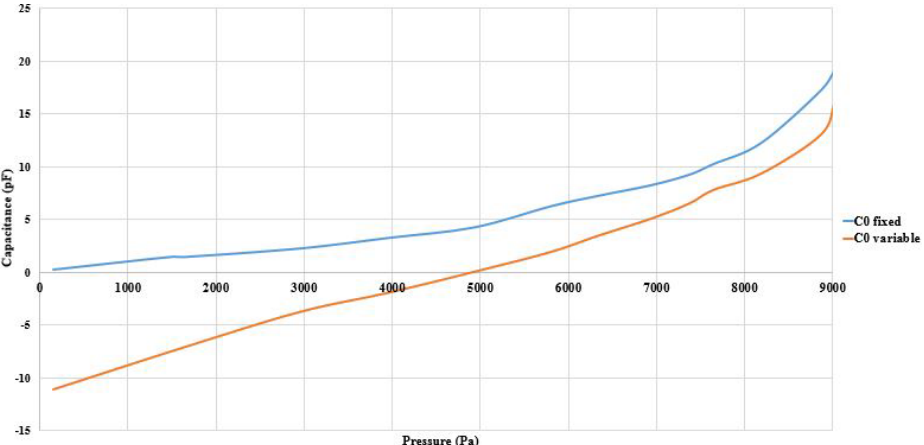
Figure 8. Responses obtained of the 3D-printed capacitive sensors at ambient temperature. The blue curve corresponds to the response of the sensor with C 0 fixed (structure A), and the orange one corresponds to the sensor with C 0 variable (structure B). Table 3. Sensitivity and nonlinearity according to the considered pressure measuring range, for d i = 75µm. P/P max